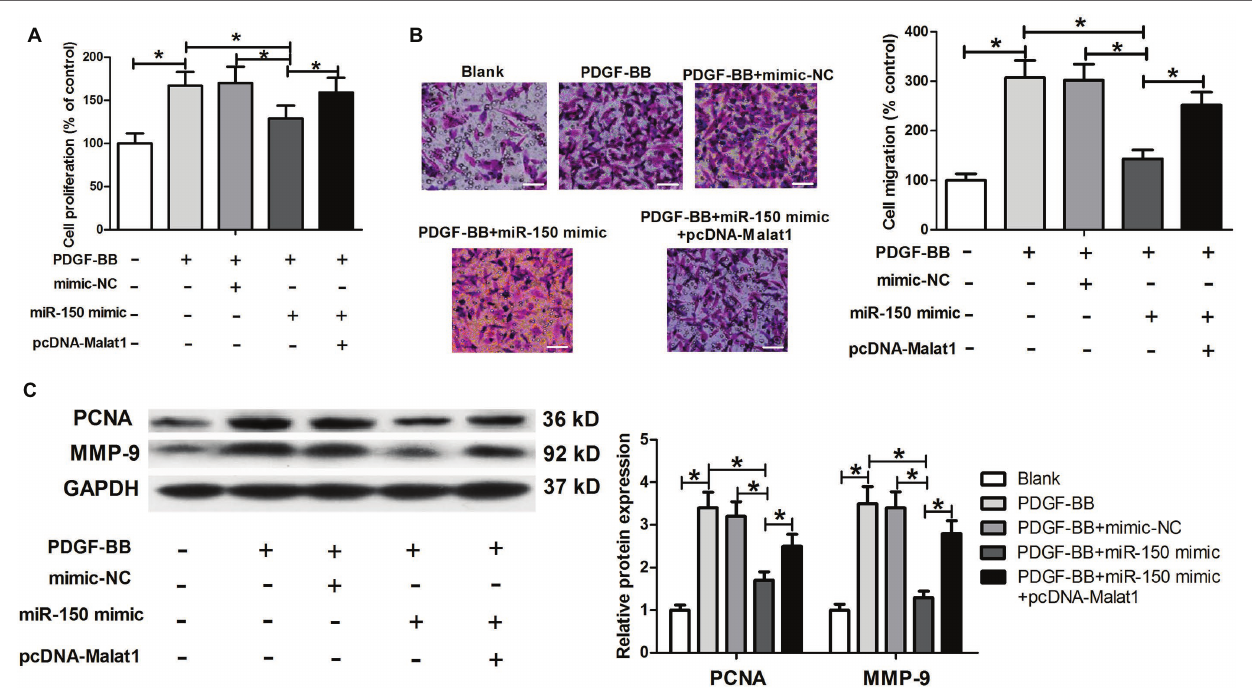
FIGURE 3 | miR-150 inhibits PDGF-BB-induced ASMC proliferation and migration, and this inhibitory effect is markedly reversed by Malat1 overexpression. ASMCs are transfected with mimic-NC, miR-150 mimic, or miR-150 mimic + pcDNA-Malat1, and then used for proliferation and migration detection. (A) Cell proliferation assessed by MTT assay. (B) Cell migration detected by Transwell assay (scale bar: 100 μ m). (C) PCNA and MMP-9 expression detected by western blot assay. * p <